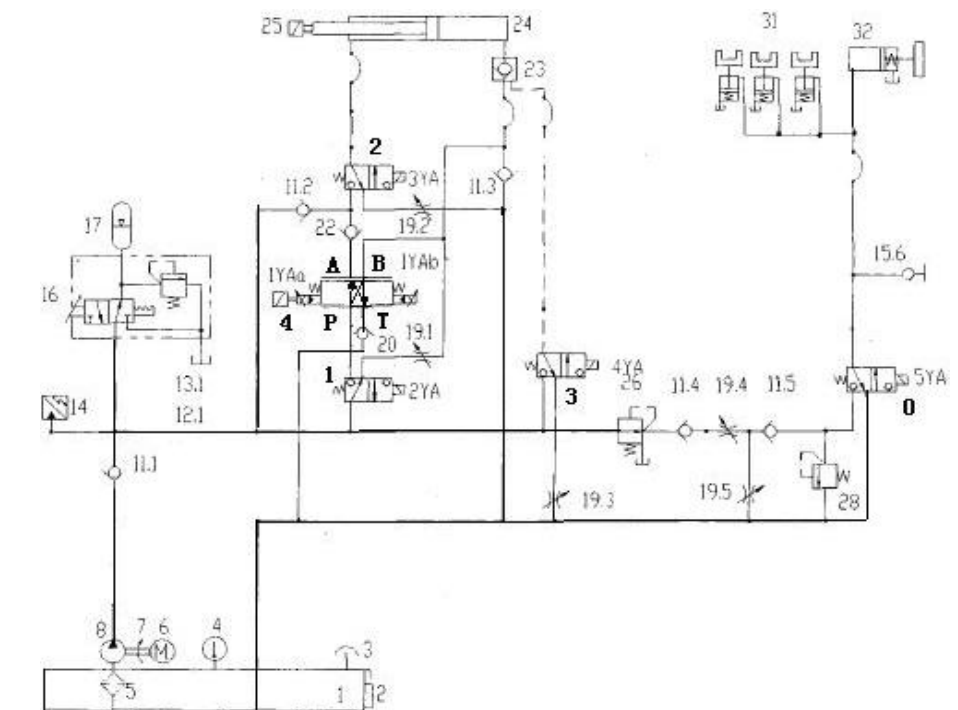
Figure 3. Schematic diagram of hydraulic variable pitch system of VESTAS V39 wind